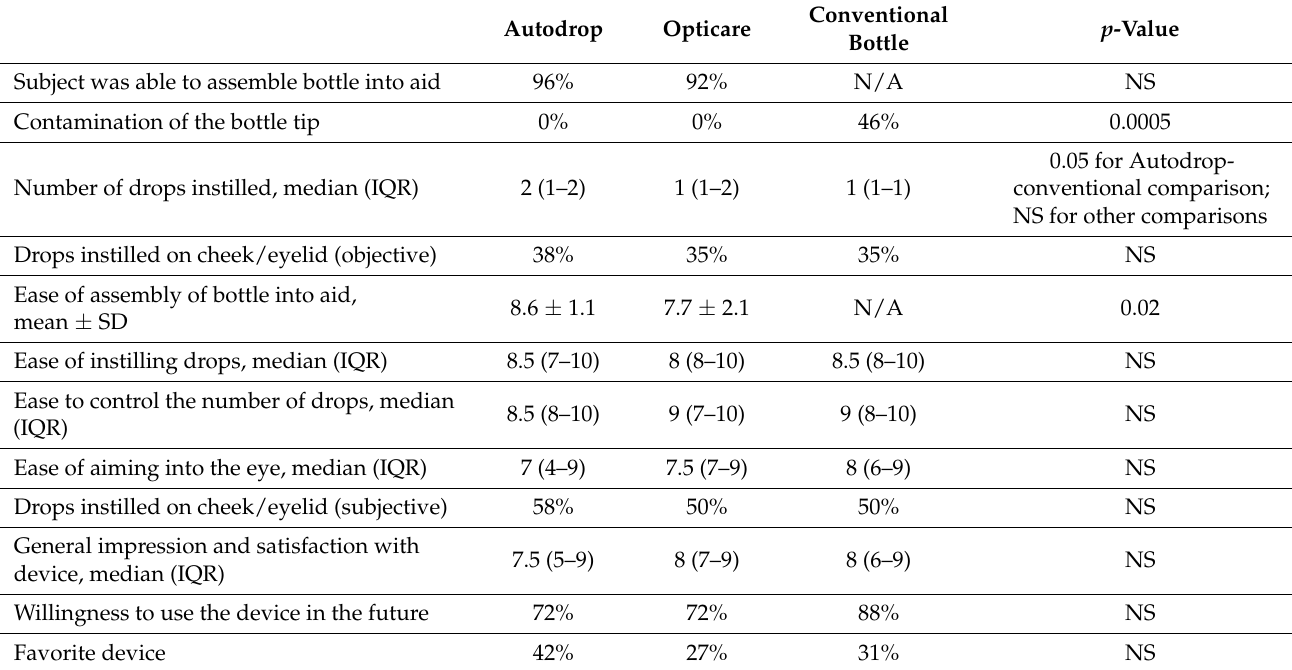
Table 2. Objective and subjective assessment of the Autodrop, Opticare and conventional bottle by 26 subjects.